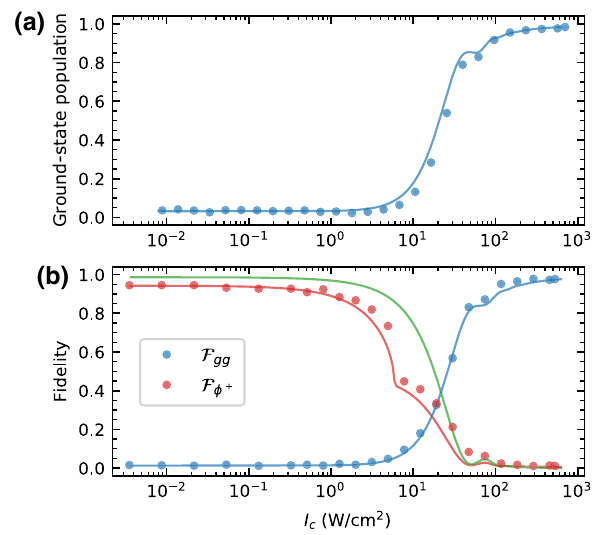
FIG. 3. (a) The probability of finding an atom in | g (cid:3) after an attempted π pulse to | r (cid:3) , for varying control intensities I c with (cid:3)/( 2 π) = − 5 GHz. At high intensities, the population trans- fer is strongly suppressed and 98.7(2)% of the atoms remain in | g (cid:3) . (b) The final-state fidelity with | φ + (cid:3) (red points, experimen- tal lower bound) and | gg (cid:3) (blue) after a π pulse in an array of dimers with a strong intradimer Rydberg blockade. The control beam switches the final state from having > 0.948(12) fidelity with | φ + (cid:3) , to 0.978(3) fidelity with | gg (cid:3) . The curves show simu- lations of the same quantities using parameters from Fig. 2(a) and adding phenomenological dephasing and detection errors. The green curve shows the exact fidelity F φ + , while the red curve shows the experimentally measurable lower bound on F φ +